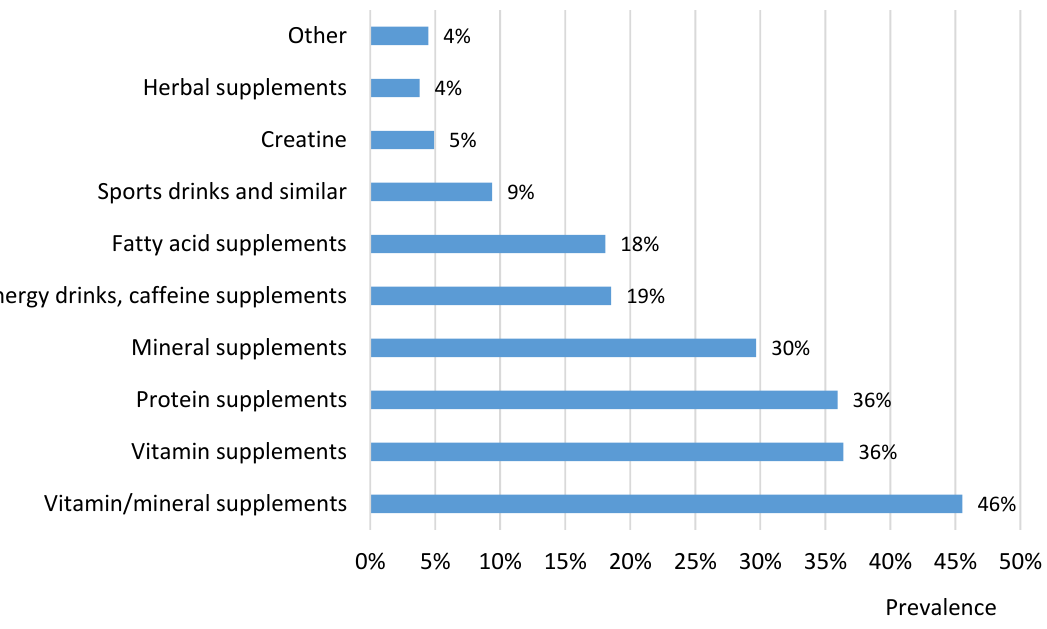
Figure 1. Prevalence of use of different types of food supplements and similar products among participants recruited from the Slovenian Armed Forces during a 12-month period ( n = 448).